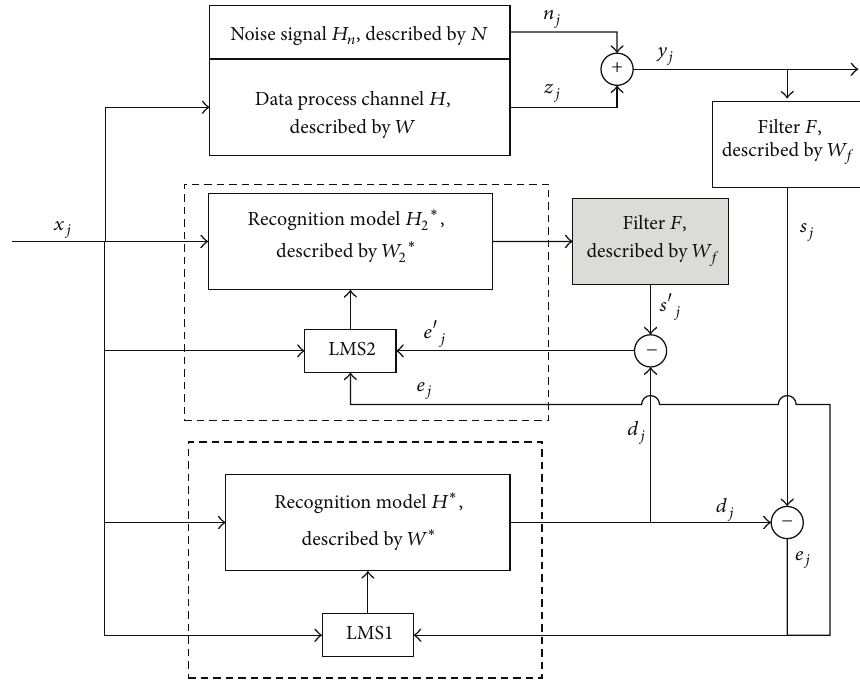
Figure 10: Dynamic modelling principle based on LMS